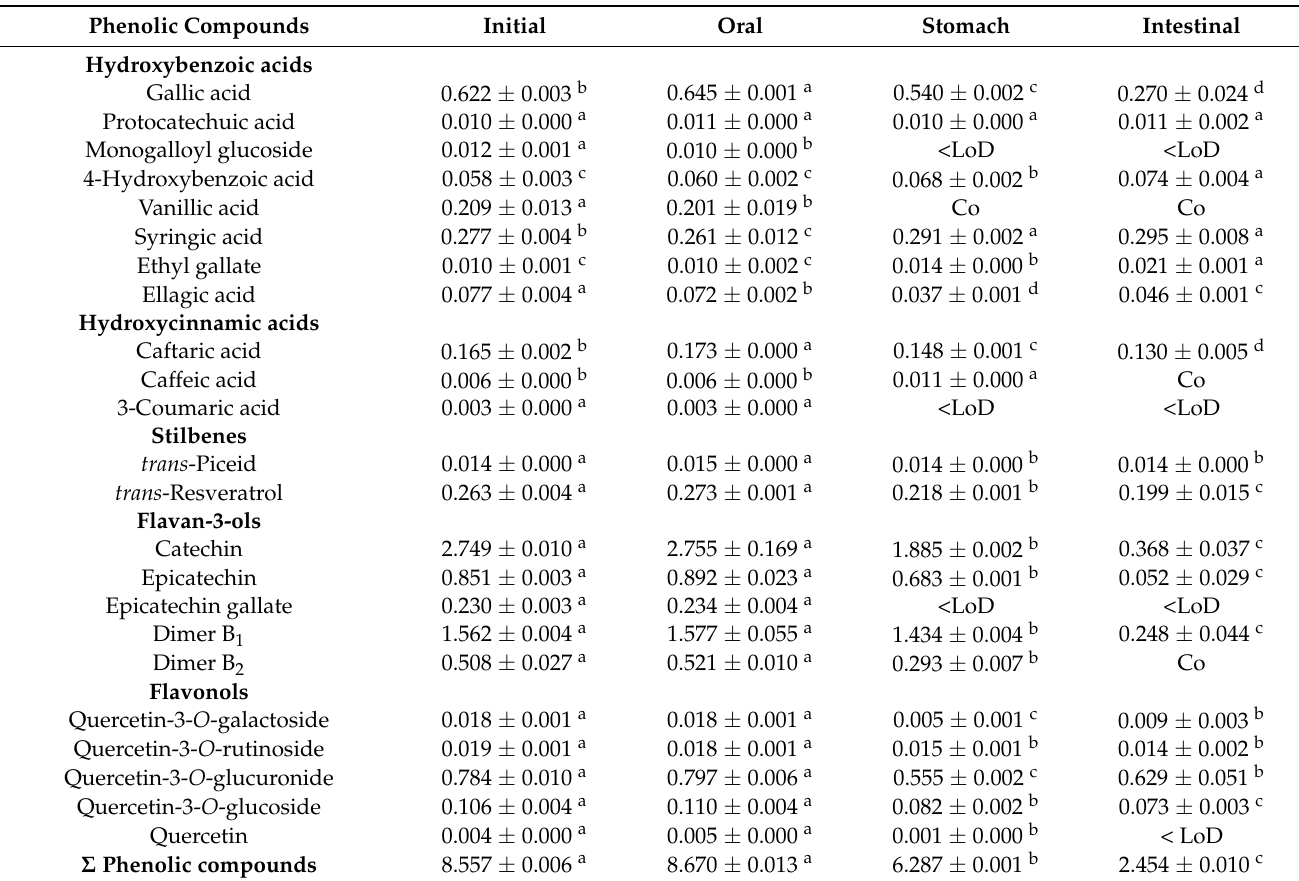
Table 3. Individual phenolic composition (monomers and oligomers) of HPE during a simulated digestion process (mg compound/g